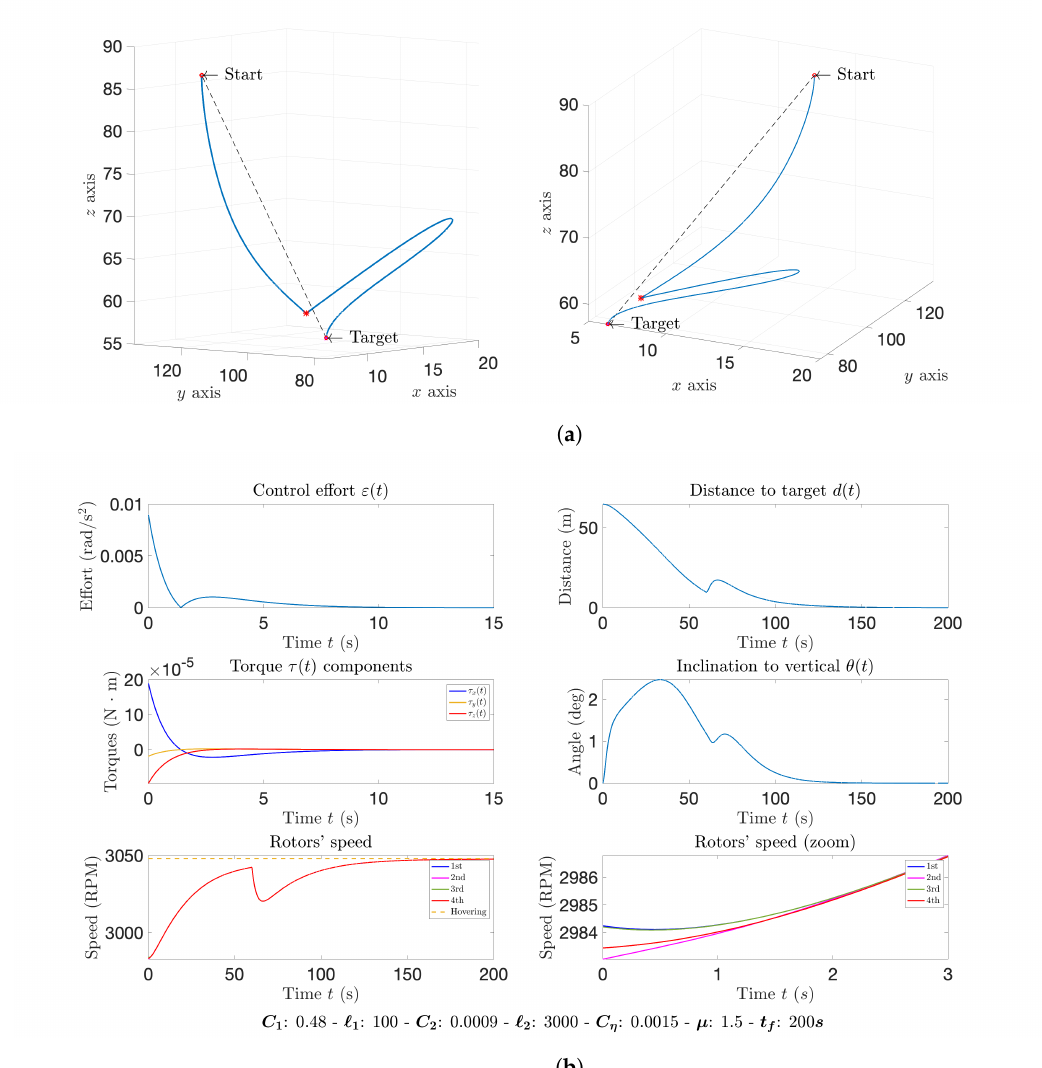
Figure 10. Experiment: Single impulsive hit. On the target approaching plot, a red asterisk denotes the point on the trajectory where the disturbance hits. ( a ) Target approaching trajectory; ( b ) Con- trol